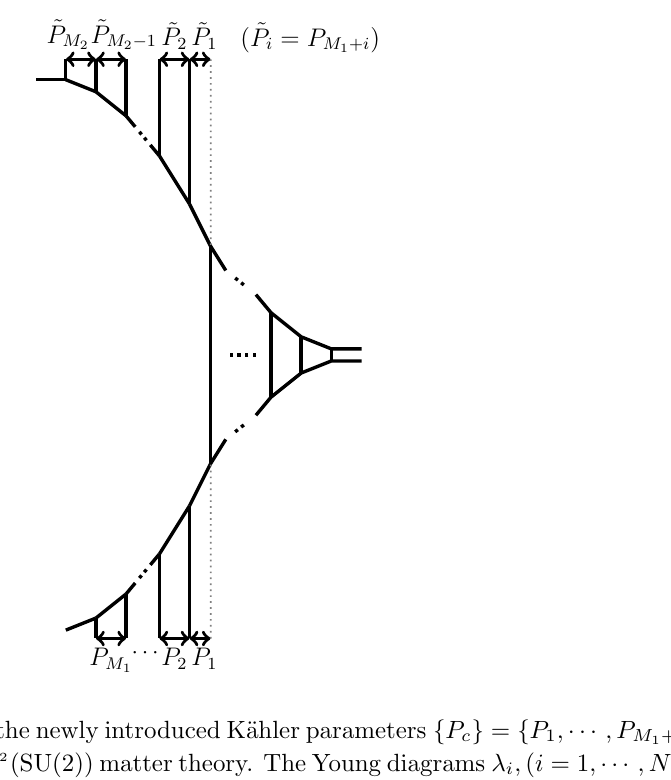
P c = P 1 ; ; P M to 1 + M 2 g f g f (cid:1) (cid:1) (cid:1)